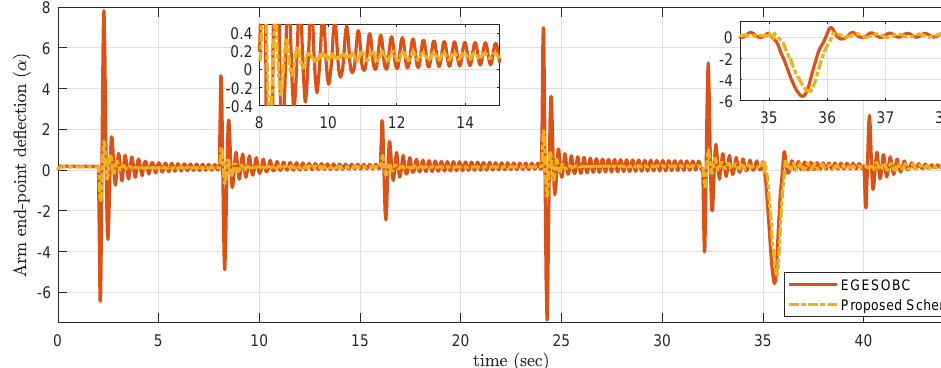
Figure 16. Experimental result of arm end-point deflection α .